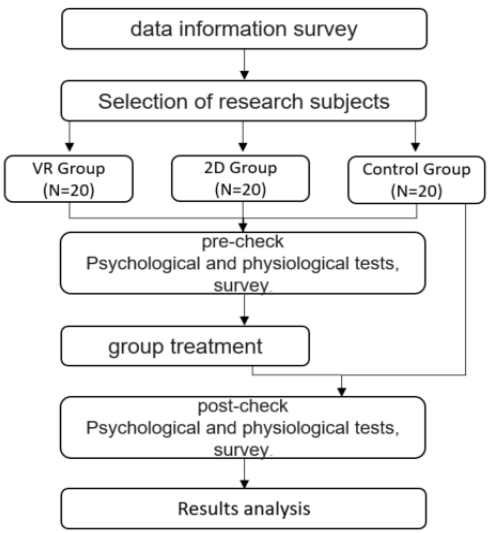
Figure 1. Research process.